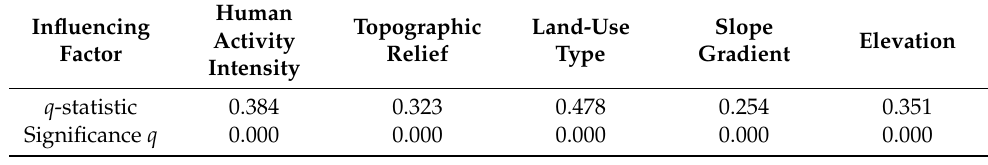
Table 4. Factor detection results.